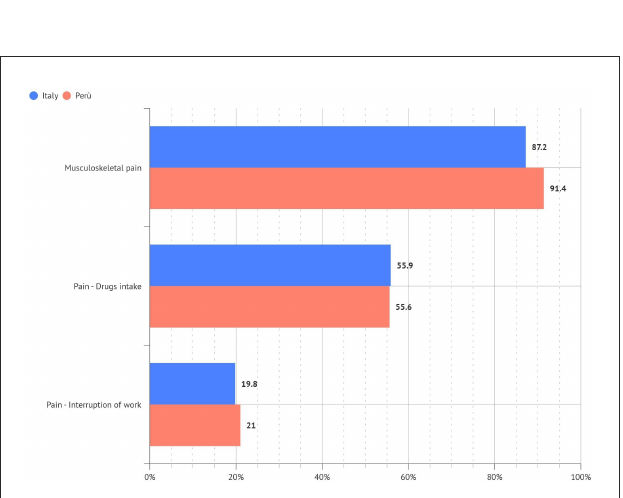
FIGURE9 Relation between pain, working hours, work inability, and drug